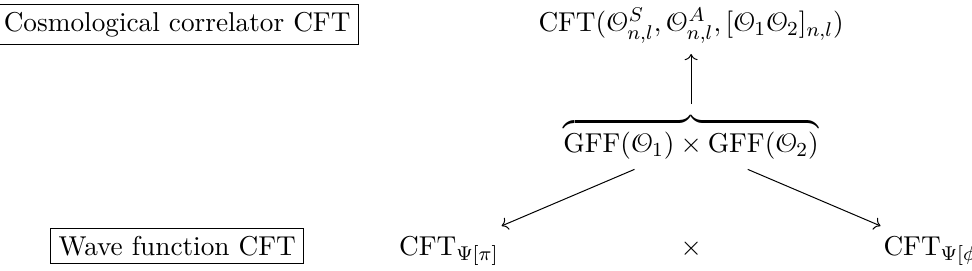
and O A are orthogonal linear combinations of n,l n,l